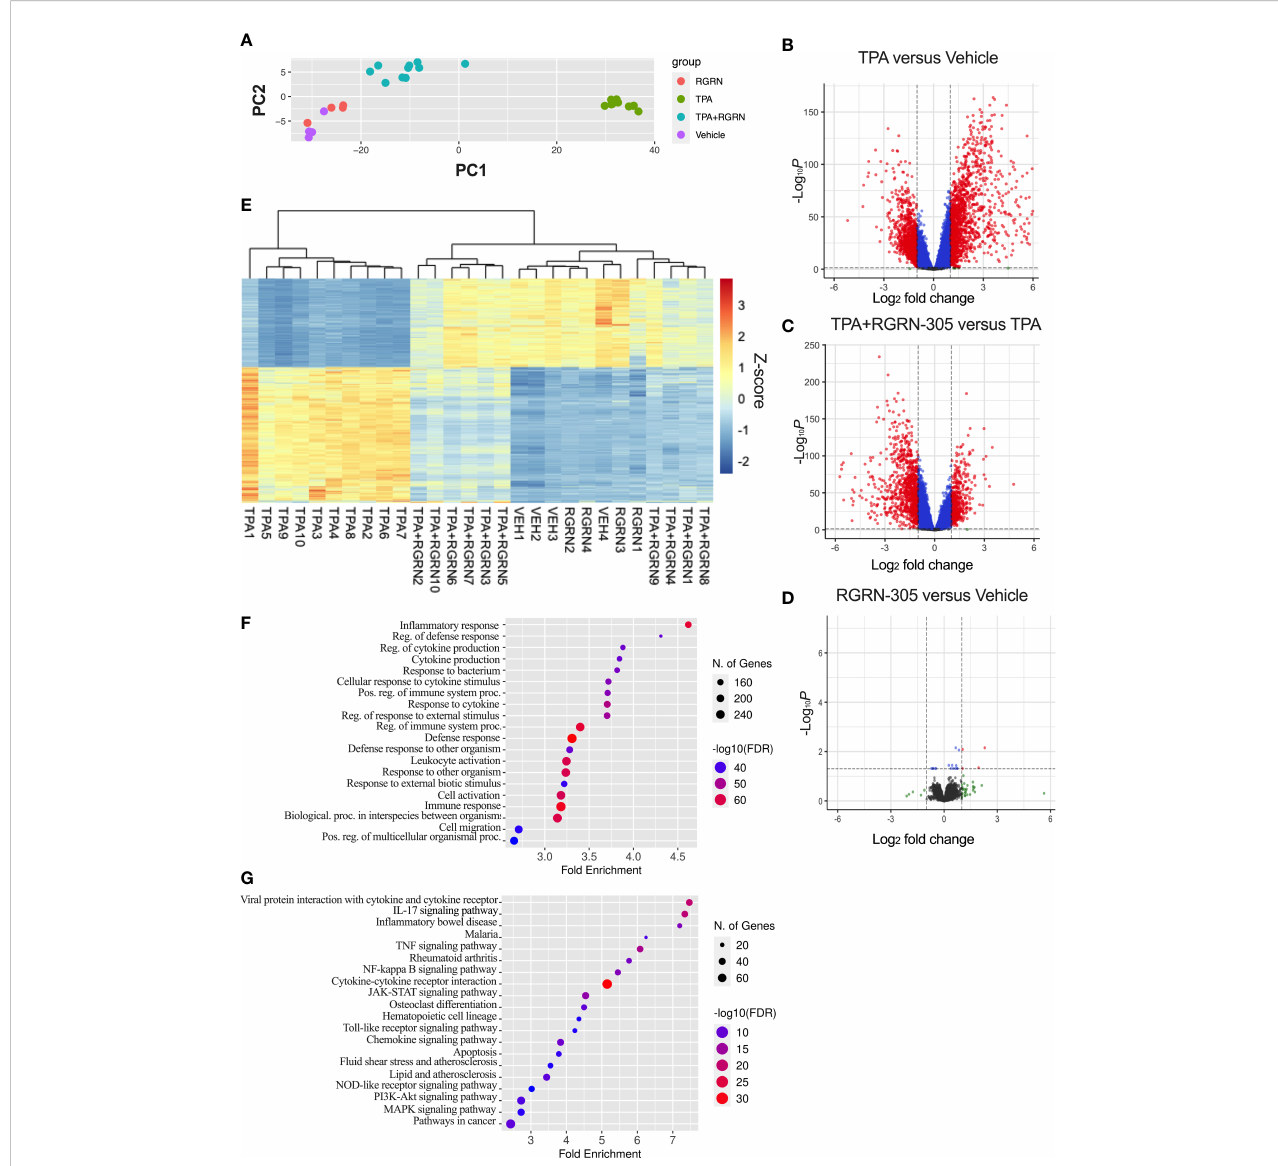
FIGURE 5 RNA sequencing of ear biopsies from mice 4 hours post-TPA challenge. Number of mice in treatment groups: vehicle = 4, RGRN-305 = 4, TPA = 10, TPA+RGRN-305 = 10). (A) Principal component analysis (PCA) performed on regularized log (rlog) transformed normalized counts for the 28 samples. (B – D) Volcano plots depicting log 2 fold change (x-axis) and adjusted p-values (y-axis) comparing the different treatment groups. The dashed horizontal lines indicate a q-value of 0.05, whereas the vertical lines mark a log 2 fold change of 1. Red dots represent differentially expressed genes (DEGs). Genes were fi ltered to include those with a base mean > 50 (mean of normalized counts of all samples). (E) Heatmap of DEGs upon TPA-induced in fl ammation (log 2 fold change > 1 and base mean > 50). The gene expression levels are normalized z-score values determined from rlog normalized counts. Rows represent genes, whereas the columns represent each sample. (F, G) Enrichment analyses of Gene Ontology biological processes (F) and KEGG pathways (G) signi fi cantly enriched in downregulated DEGs (log 2 fold change < -1) comparing TPA+RGRN-305 versus TPA. The top 20 terms ranked by smallest false discovery rate are presented. DEG, differentially expressed genes. TPA,